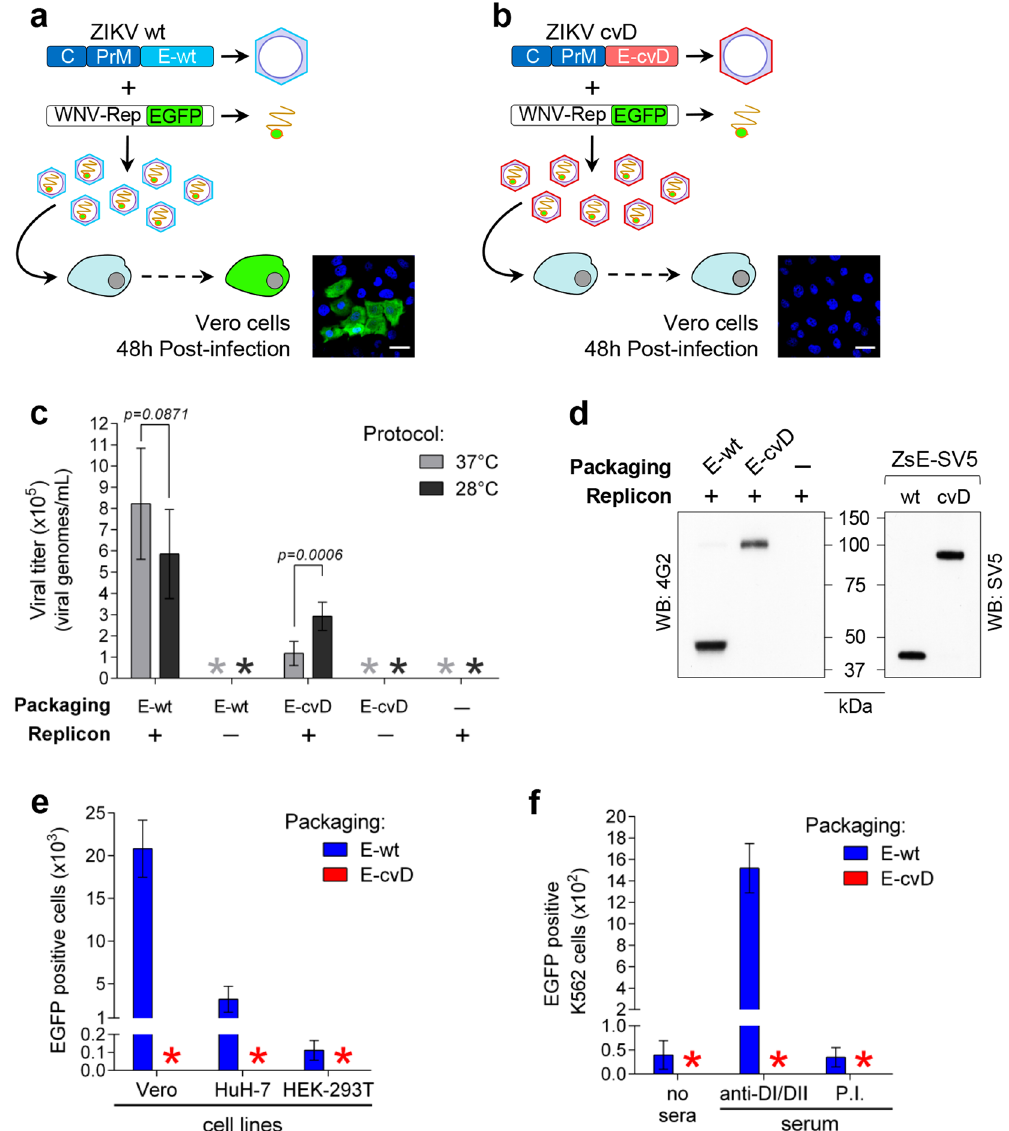
Figure 3. Pseudoviral particles packaged with ZIKV E-cvD protein. ( a , b ) Schematics of the ZIKV-wt ( a ) and -cvD ( b ) constructs and the WNV replicon used to produce pseudoviral particles, tested for infectivity (EGFP expression) on Vero cells. Images correspond to representative experiments (Bar, 30 μ m). ( c ) Yield of pseudovirus determined by RT/PCR of the replicon-derived RNA, on samples obtained with ZIKV E-wt packaging construct with (for each temperature, n = 7; t = 1,863 df = 12) and without (for each temperature, n = 6) replicon, or ZIKV E-cvD packaging construct with (for each temperature, n = 6; t = 4,896 df = 10) and without replicon (for each temperature, n = 6), supernatant of cells transfected only with the WNV replicon was used as control (for each temperature, n = 6), data is represented as mean ± s.d. ( d ) Left panel, non-reducing Western blot of E protein from culture supernatants of cells transfected with WNV replicon and ZIKV E-wt or E-cvD packaging constructs, developed with mAb 4G2. Right panel, western blot of the corresponding sE SV5-tagged proteins developed with anti-SV5; migration differences correspond to the effect of the SV5 tag. ( e ) Infectivity of pseudoviral particles produced with ZIKV E-wt or E-cvD packaging constructs on Vero (for both preparations, n = 5), HuH-7 (for both preparations, n = 5) and HEK-293T cells (for both preparations, n = 5), determined as EGFP positive cells at 48 h post-infection (All cells were infected using 2 × 10 4 viral particles as quantified by RT/PCR), data is represented as mean ± s.d. * , undetected. ( f ) Infectivity of same pseudoviral particles as in ( e ) on K562 cells in the absence of serum (for both preparations, n = 5) or in the presence of an anti-DI/DII serum (for both preparations, n = 5) or a negative control pre-immune serum (for both preparations, n = 5), data is represented as mean ± s.d. * ,